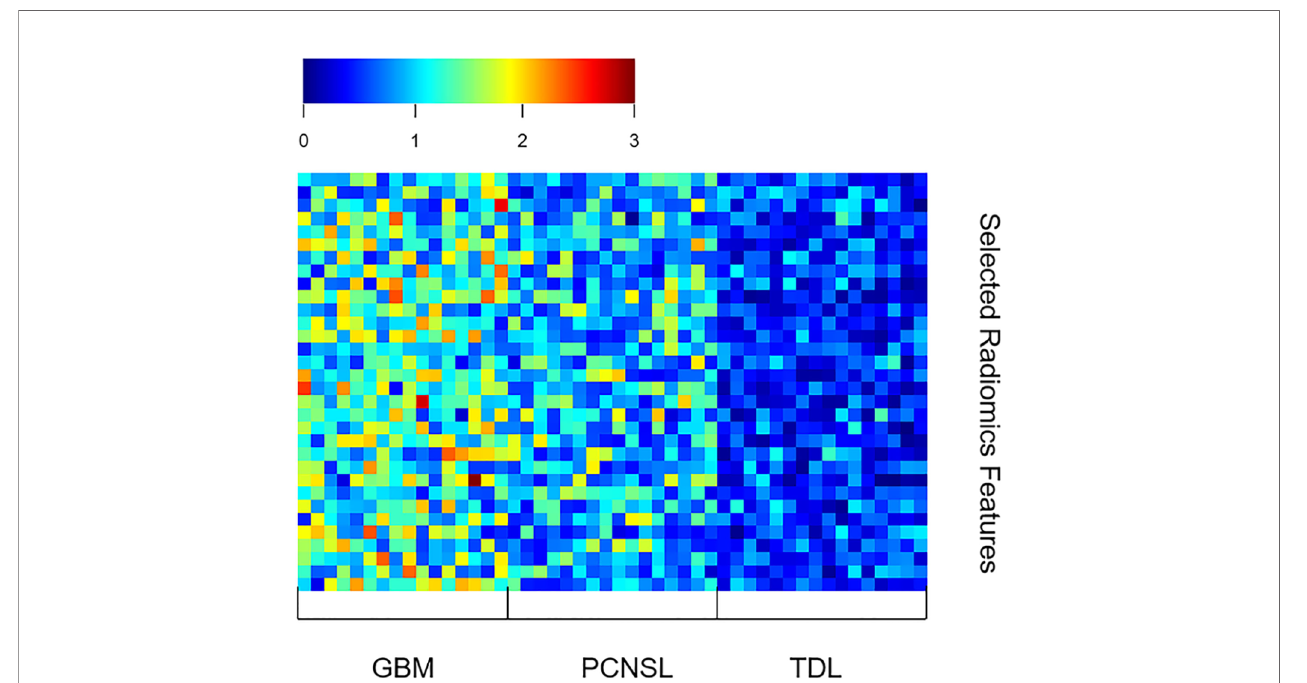
FIGURE 5 | The selected radiomics features of GBM, PCNSL, and TDL at the optimal k